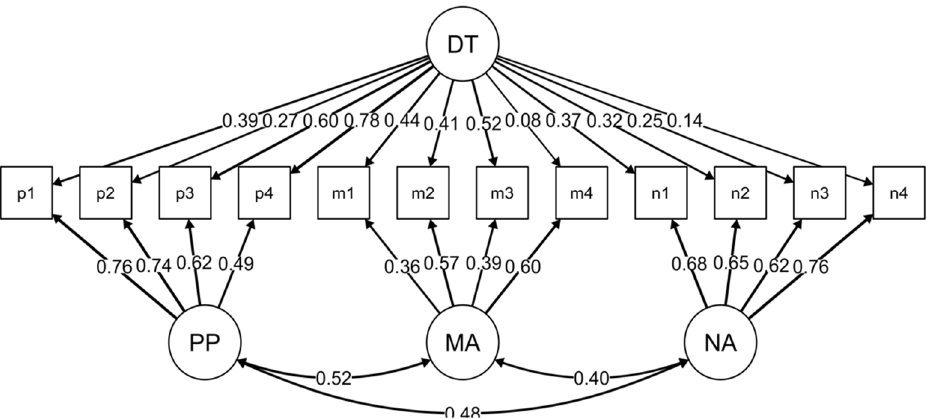
Figure 1. Structural equation model. DT = Dark Triad, PP = psychopathy, MA = Machiavellianism, NA = narcissism, p1–p4 = parcels for psychopathy, m1–m4 = parcels for Machiavellianism, n1–n4 = parcels for narcissism. Table 4. Regression weight